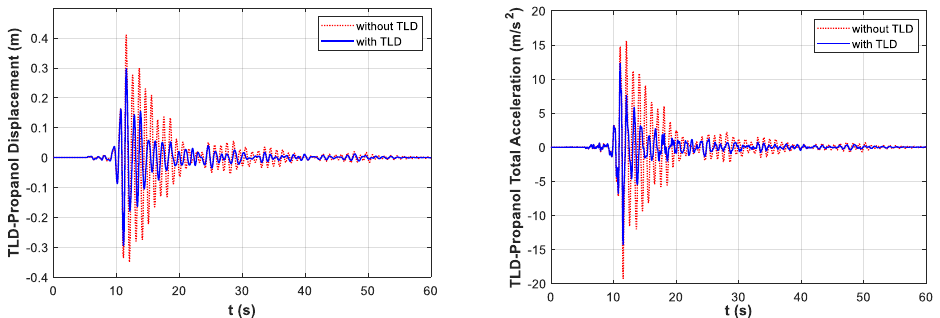
Figure 10. AHS optimization of the 10-story structure displacement–time and total acceleration–time graphs in the DUZCE/BOL090 earthquake record for TLD – propanol.